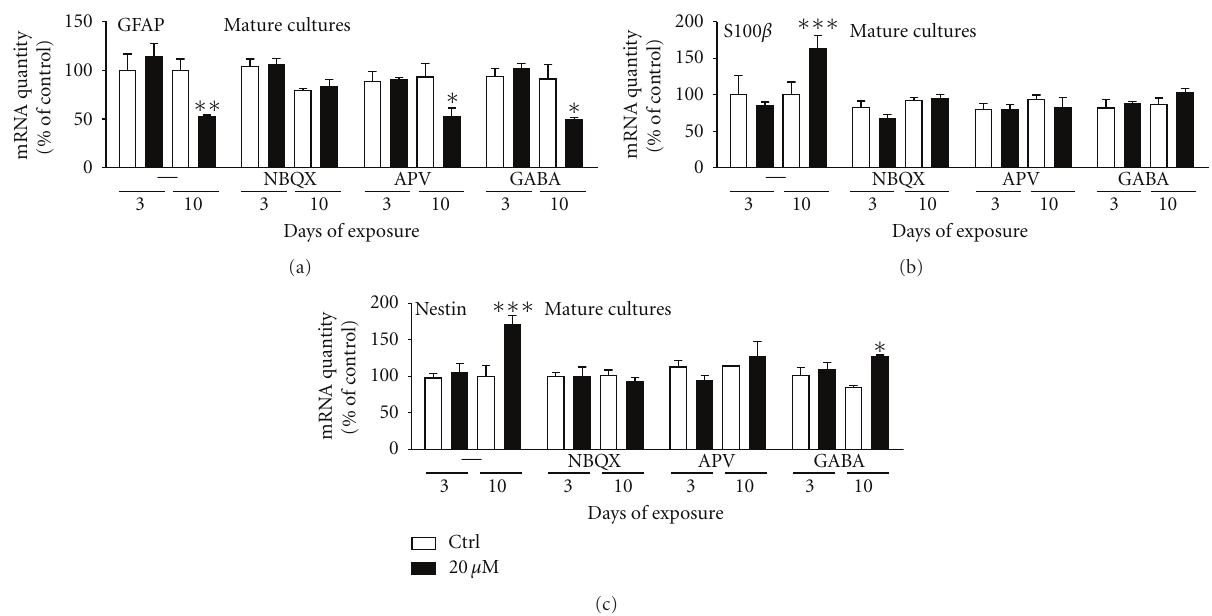
Figure 6: Changes in the mRNA levels of astocytic and precursor markers in mature primary cultures of CGCs exposed to 20 μ M domoic acid alone or in combination with antagonists for the AMPA-R (NBQX, 20 μ M), NMDA-R (APV, 100 μ M) or the neurotransmitter GABA (10 μ M) at 7 DIV for 3 or 10 days. NBQX but not APV or GABA prevented the domoic acid induced downregulation of (a) GFAP mRNA expression. Note that NBQX, APV and GABA could prevent the domoic acid induced up-regulation of (b) S100 β and (c) nestin mRNA levels. Gene expression levels were normalized to the standard calibrator, the housekeeping gene 18S rRNA and the mRNA expression at 1 DIV. Data represent mean ± S.E.M. of three independent experiments performed in duplicates. ∗ P < 0 . 05 ∗∗ P < 0 . 01 ∗∗∗ P < 0 . 001 comparing treated to control (un-treated)